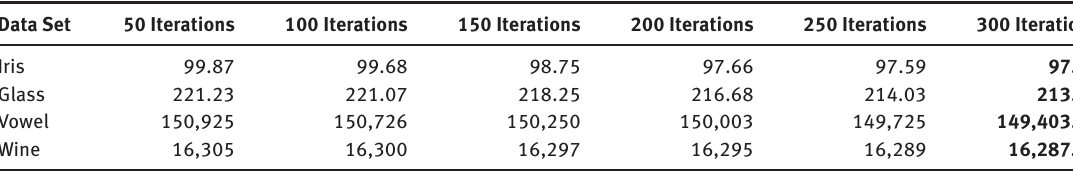
Table 3: SICD Variation with Number of Iterations: SSO Clustering.